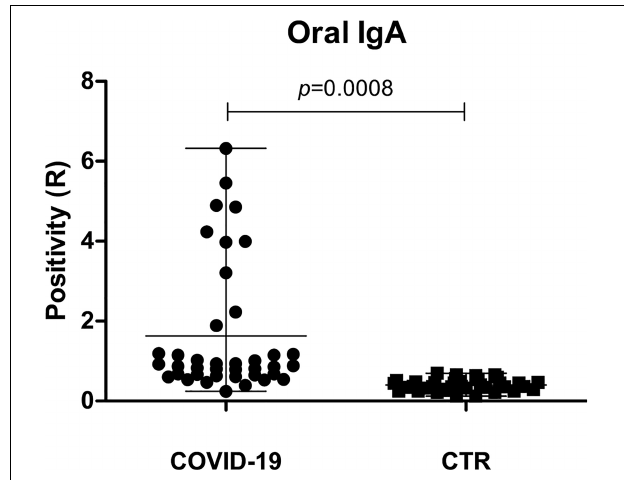
FIGURE 7 | Mucosal sIgA response in the oral cavity of COVID-19 and control (CTR) subjects. The positivity is expressed as the ratio (R) between the value detected in the sample and the threshold control value, following manufacturer’s instructions; mean value with range is also